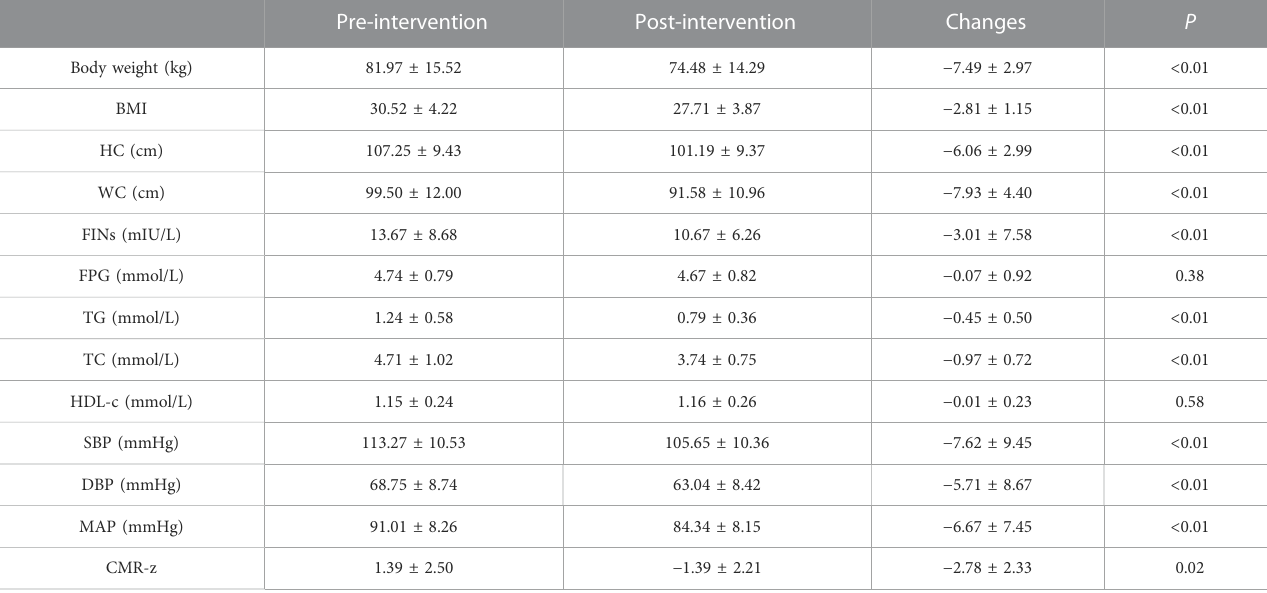
TABLE 3 Changes in morphological indicators and CMR factors.